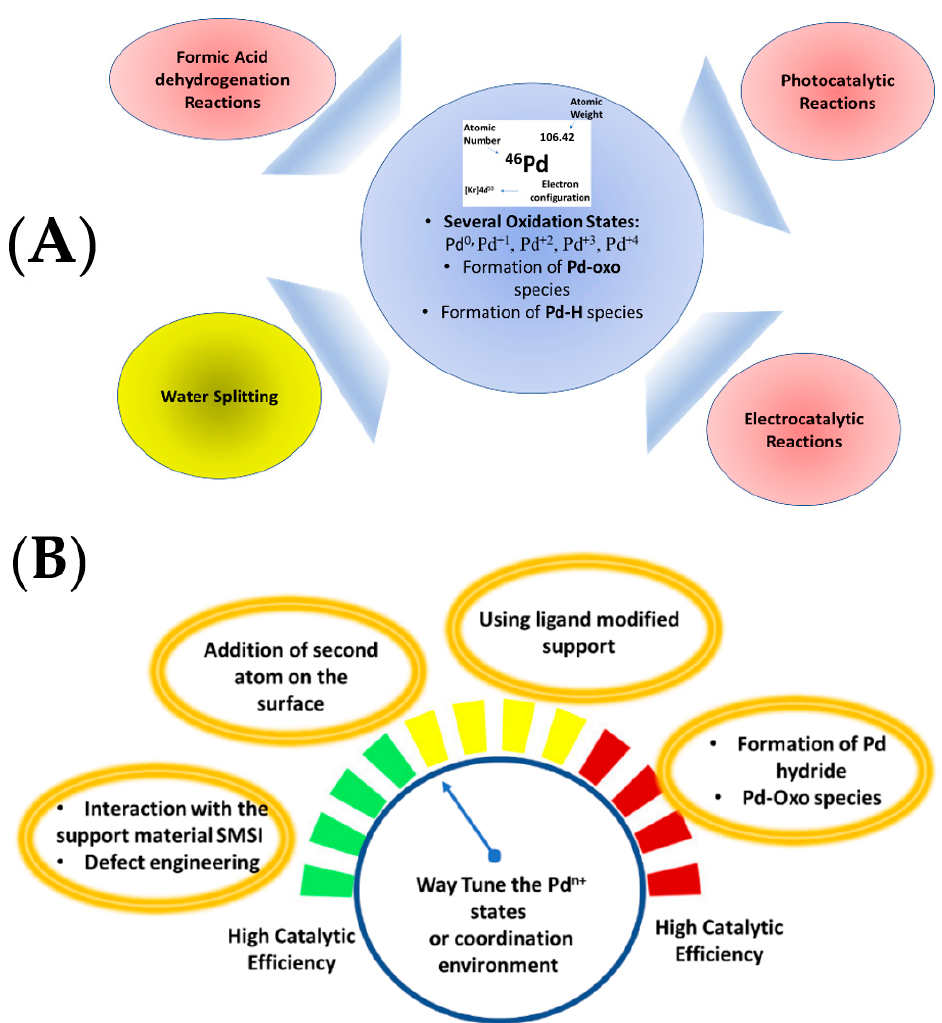
Figure 3. ( A ) Chemical properties of the palladium and possible catalytic applications. ( B ) Possible ways to tune the oxidation state and/or coordination environment of supported Pd species.